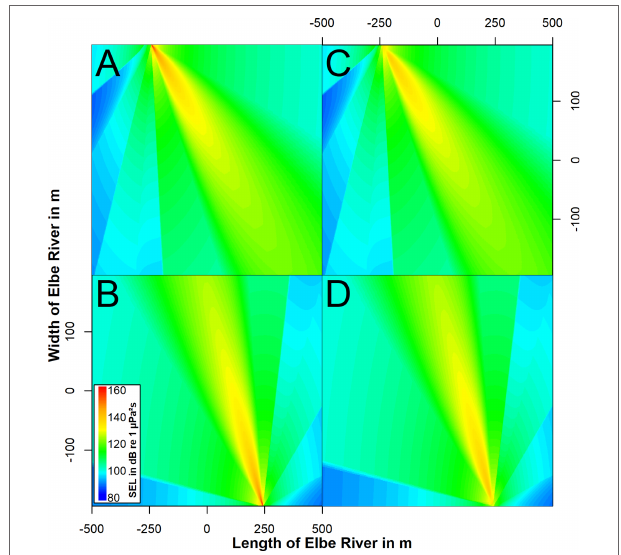
FIGURE 5 | Top view on the modelled sound field of the acoustic flowmeter on the north (top row) and south (bottom row) riverbank. The sound field is shown for depths of 5 (A, B) and 12 m (C, D) . The sound exposure level of a single pulse is shown by color-coding in dB re 1 µPa²s.